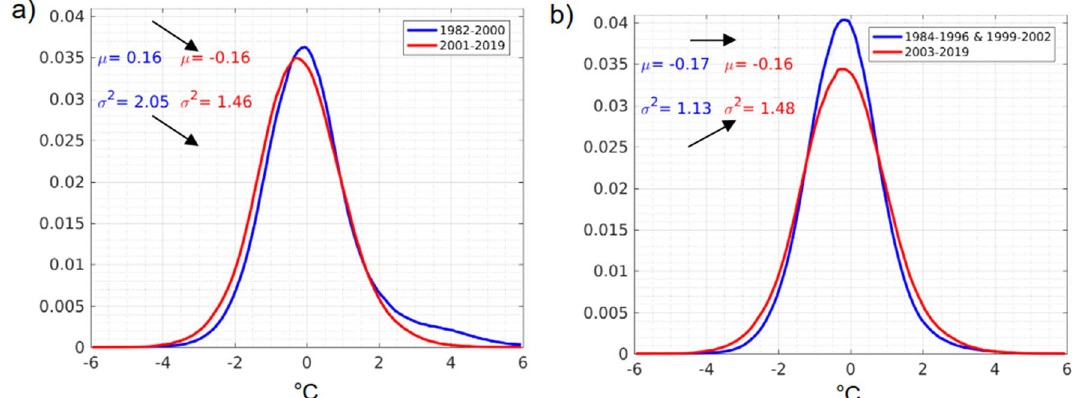
Figure 6. Probability density functions of daily SST anomalies for two periods of equal duration. The blue line represents the first half of the distribution: ( a ) 1982–2000 or ( b ) 1983–1996 and 1999–2002. The red line represent the second half: ( a ) 2001–2019 or ( b ) 2003–2019. The mean ( µ , in degrees Celsius) and standard deviation ( σ , in degrees Celsius) are also indicated for the two time periods. The figure was created using Matlab R2020b (https:// matlab. mathw orks.